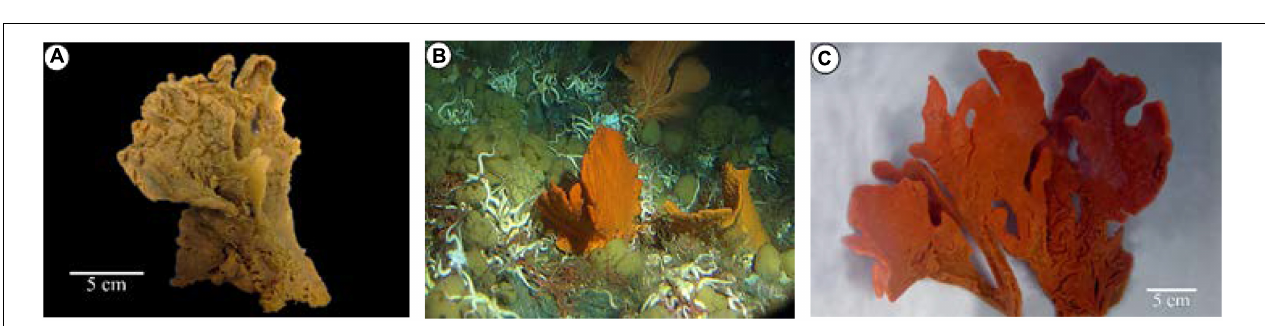
FIGURE 2 | Comparison of Monanchora pulchra and Monanchora sp. (Order Poecilosclerida, Family Crambeidae): (A) DDDBS voucher 2010-AK-49 (NIWA 92956; NHMUK2011.2.11.3), Monanchora sp., ex situ image showing pale orange-yellow coloration and deep cracks in the ectosomal membrane upon collection; (B) M. pulchra (Lambe, 1894/1895) sensu stricto , DDDBS voucher AB13-0142 (NIWA 92966): Southwest of Atka Island, Central Aleutian Islands, 150 m, collected by Robert Stone, NOAA Fisheries, Alaska on the submarine DELTA, image reprinted from Stone et al. (2011) with permission.